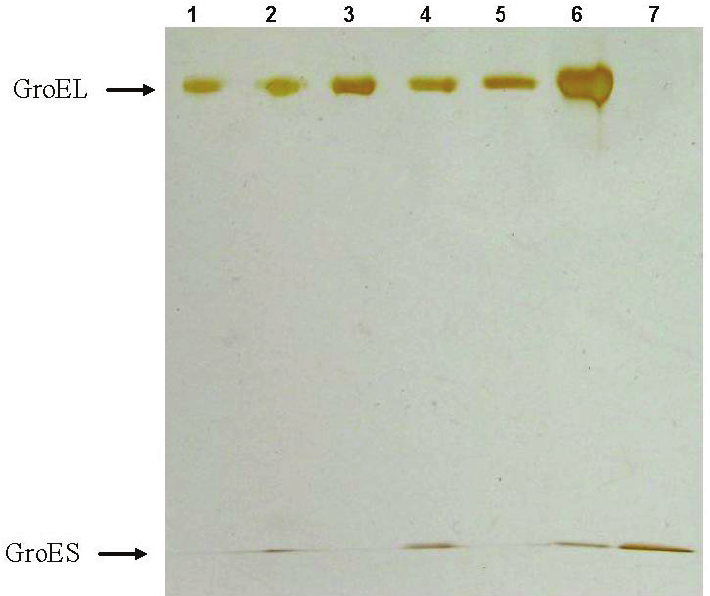
Figure 9. The second-dimension SDS-electrophoresis of the protein bands which are present at nondenaturing blue electrophoresis of GroEL reassembly reaction mixture (see Figure 8). Slots: 1 — SR1 mutant of GroEL, 2 — complex GroEL of the intermediate oligomer with GroES monomer (a few GroES are present because of some difficulty with separation of the corresponding bands – see Figure 8a), 7 — the GroES